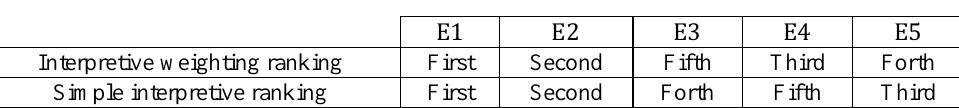
Table 18. Adaptive Ratings for the Simple and Weighted interpretive